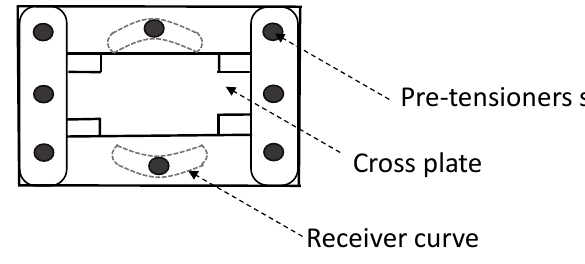
Figure 3. Pall friction damper.